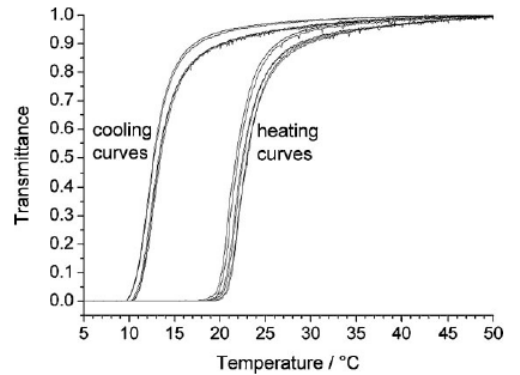
Figure 5. Hysteresis as observed by light transmittance characteristic of many Am-AA based hydrogels